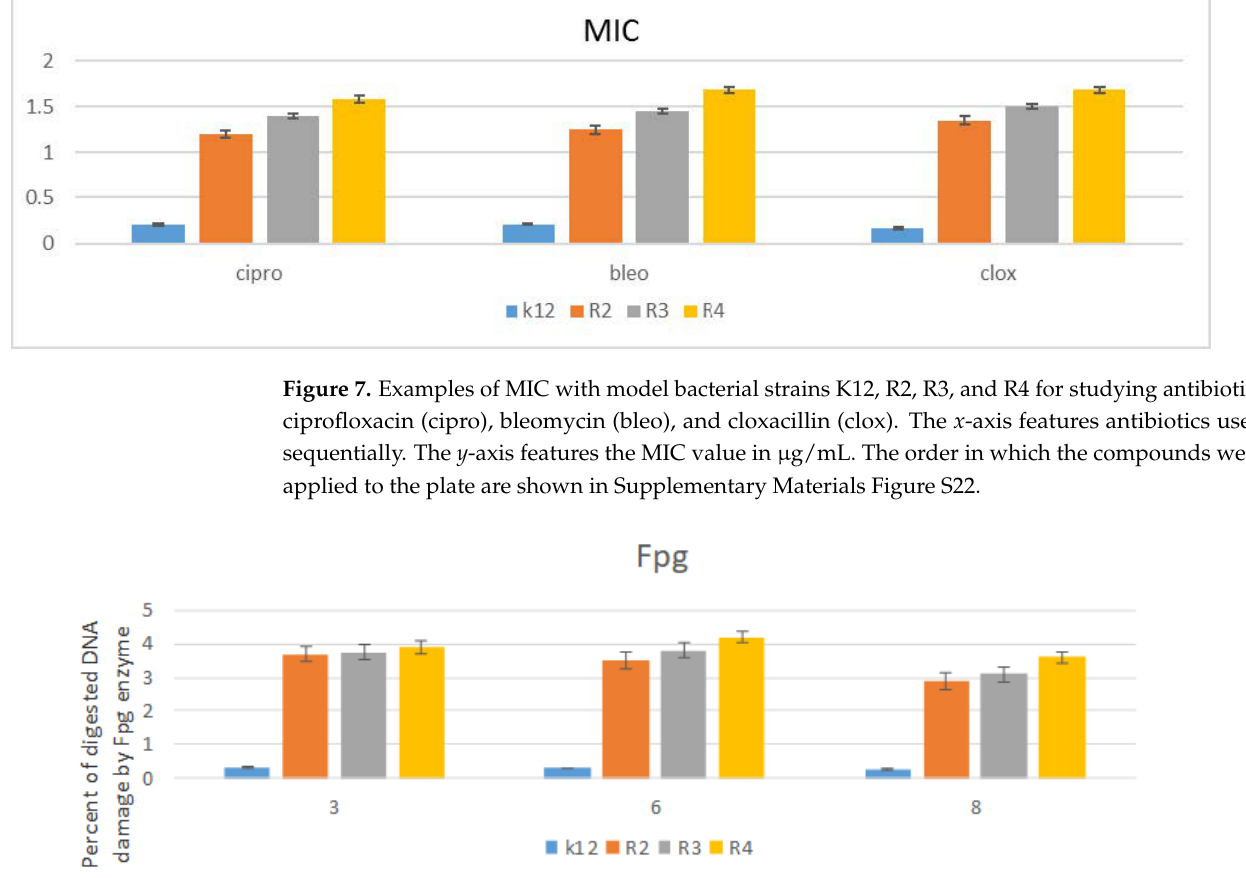
Figure 8. Percentage of plasmid DNA recognized by Fpg enzyme ( y -axis) with model bacterial, K12, and R2 – R4 strains ( x -axis). All analyzed compounds numbered were statistically significant at <0.05 * (see Table 1). The data are shown in Supplementary Materials Figure S23.